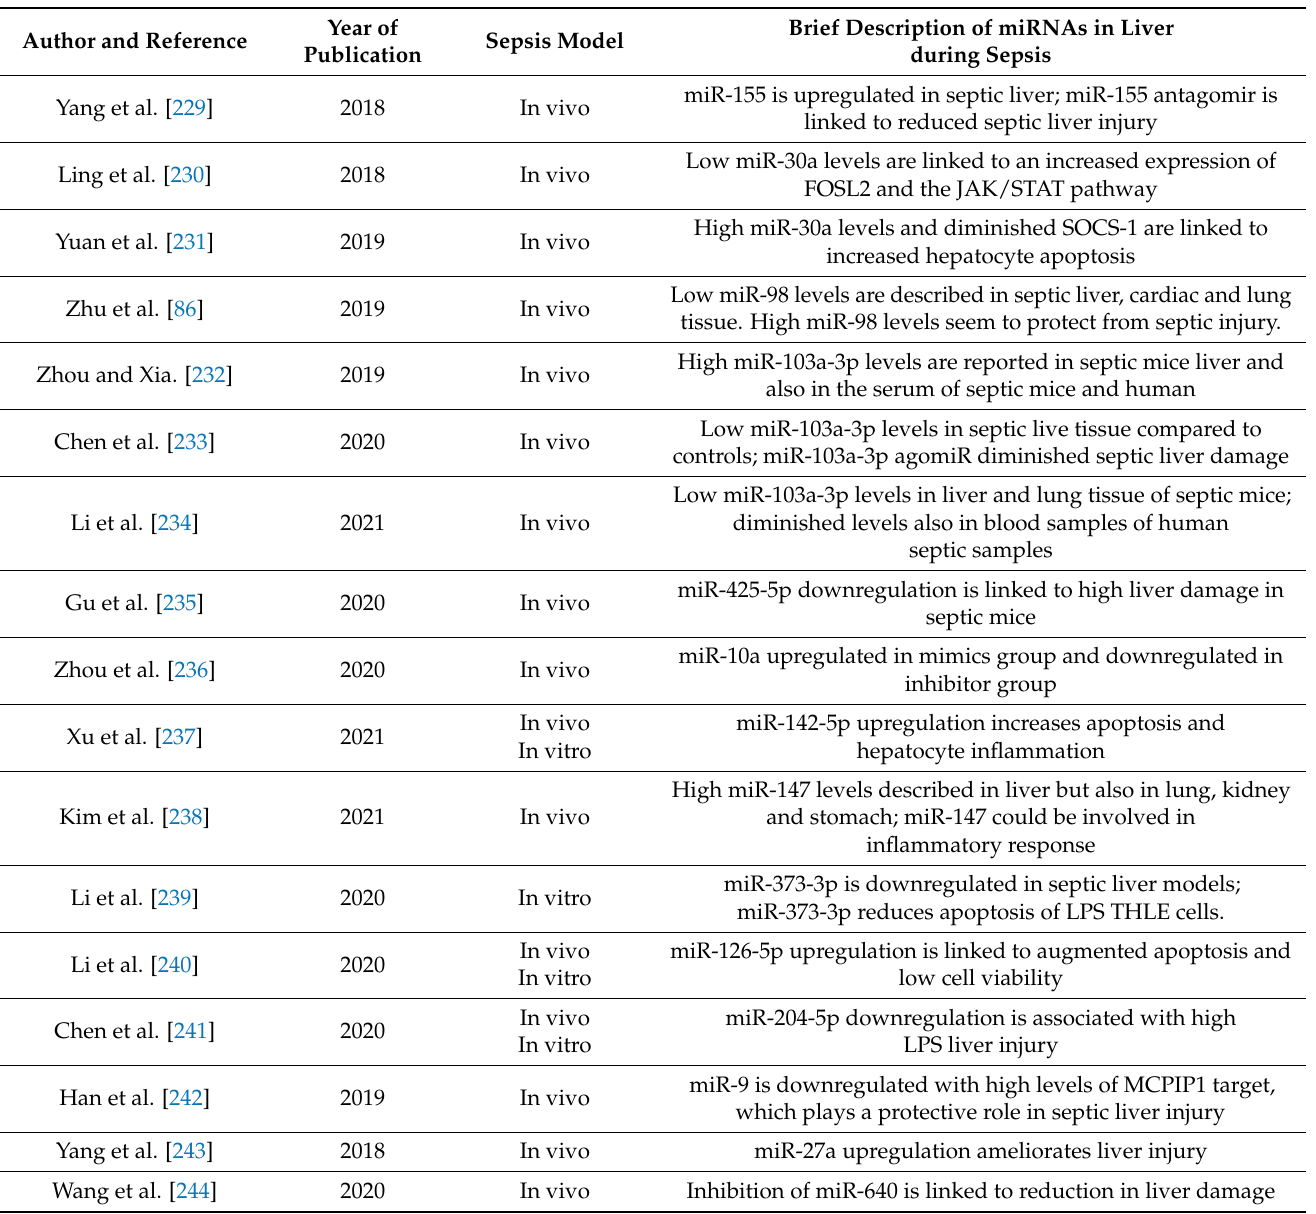
Table 5. miRNA expression in sepsis-related liver